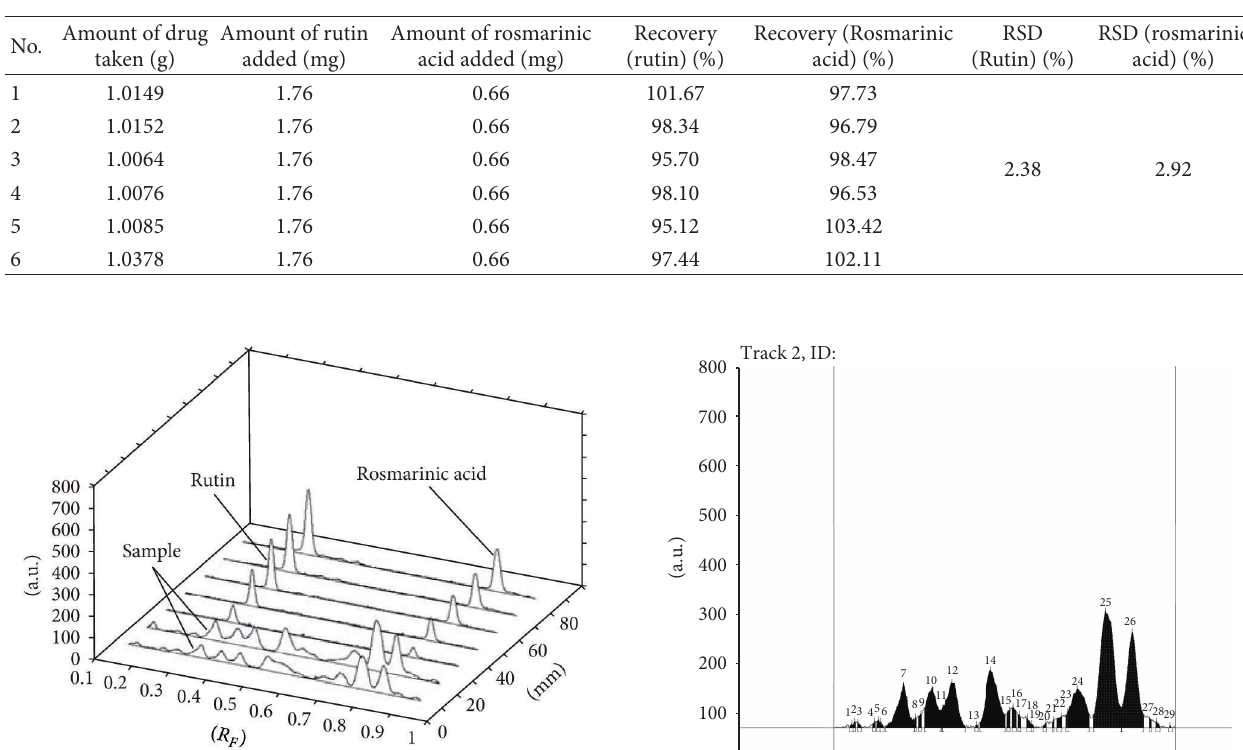
T 1: Results of recovery test of Rutin and Rosmarinic acid (